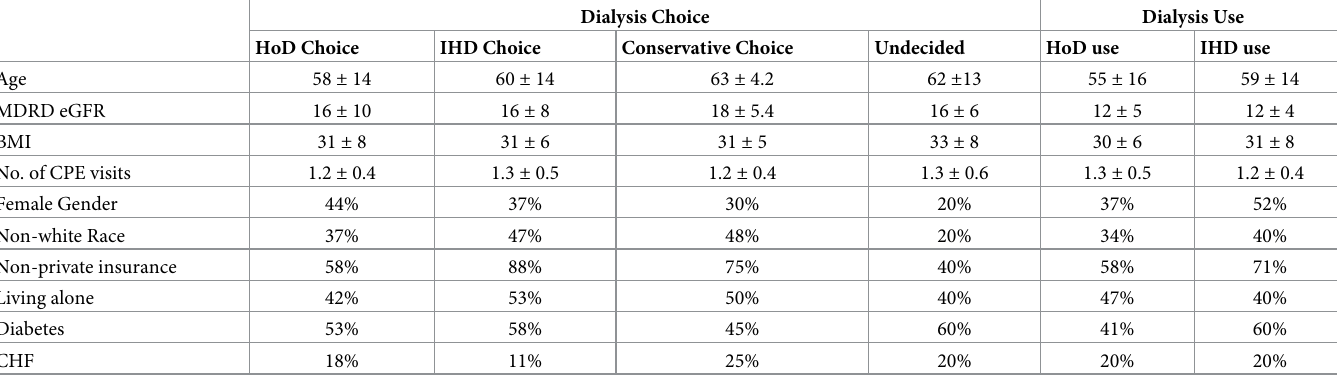
Table 1. Demographic and baseline statistics of patients by their HoD choice as well as eventual use.